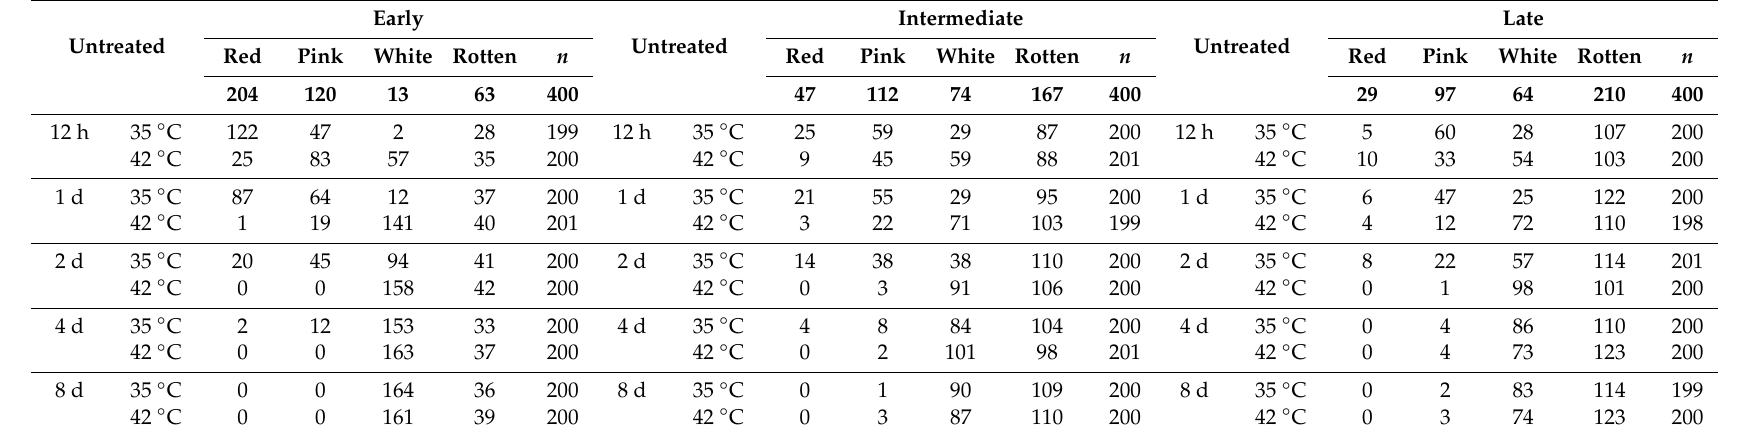
Table 1. Number of embryos for each staining, harvest, duration in water bath, and temperature after tetrazolium chloride staining (TTC) solution testing.